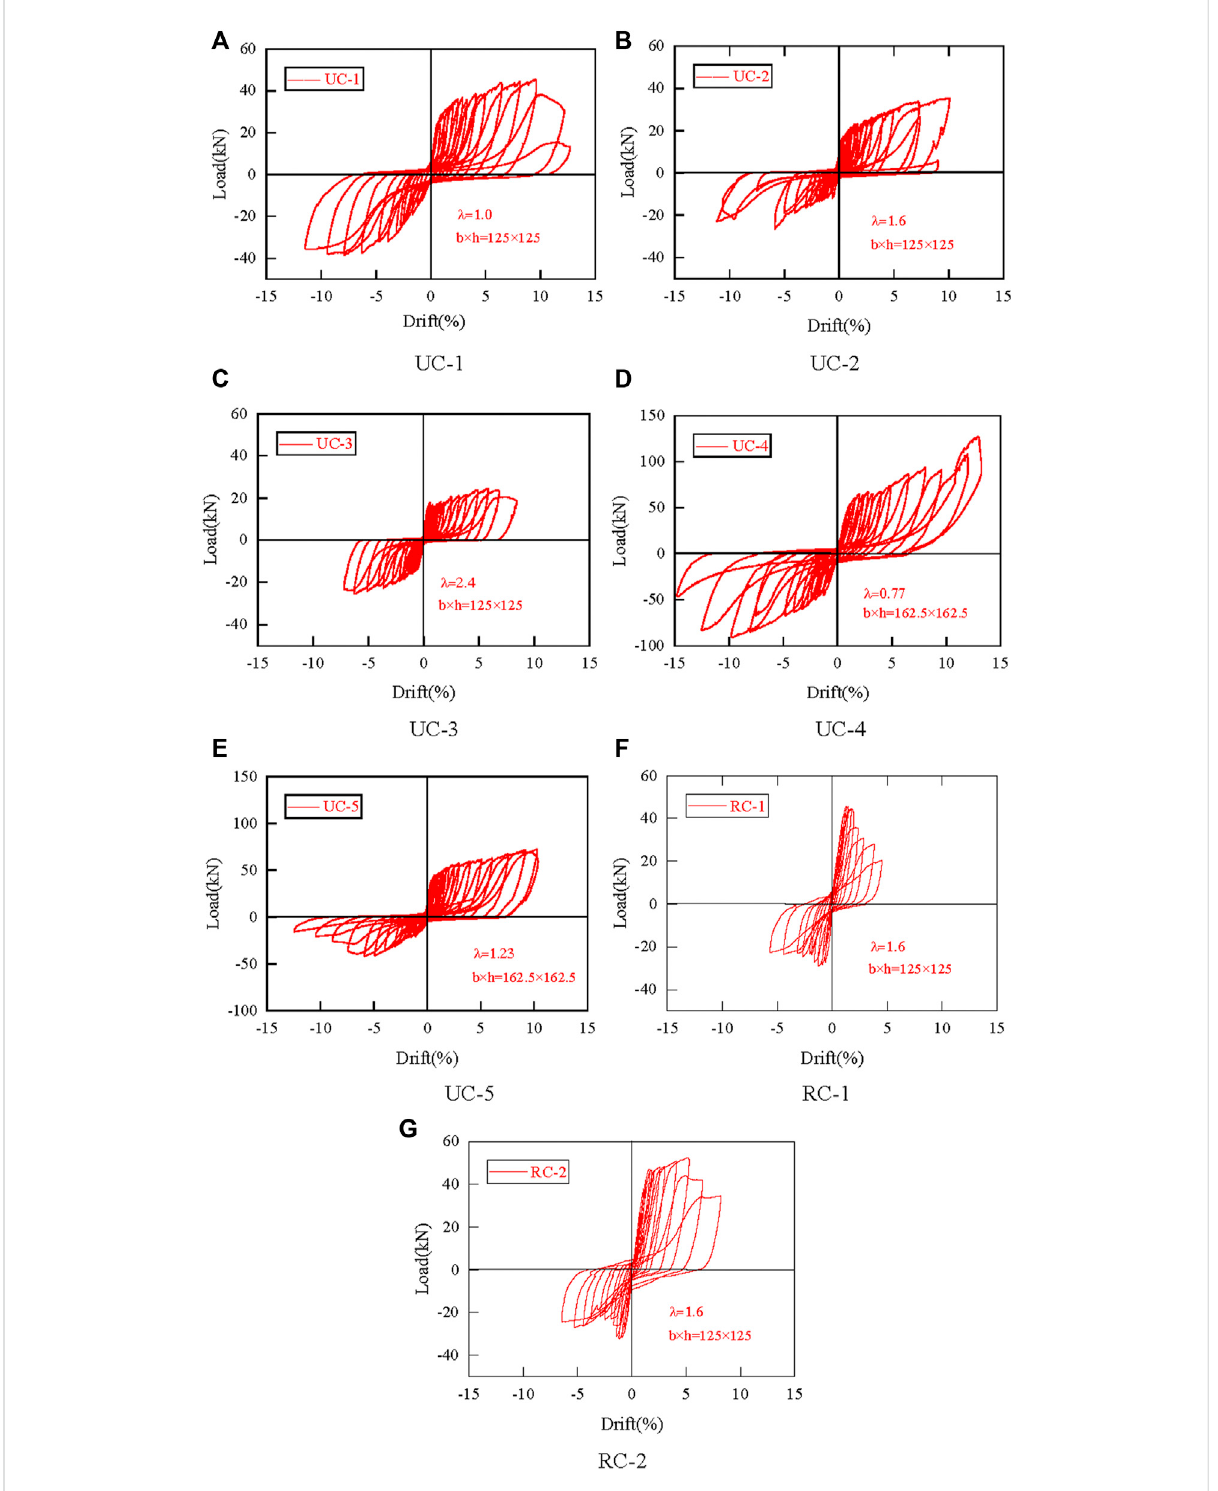
FIGURE 5 Hysteretic curves. Drift vs. load force hysterestic